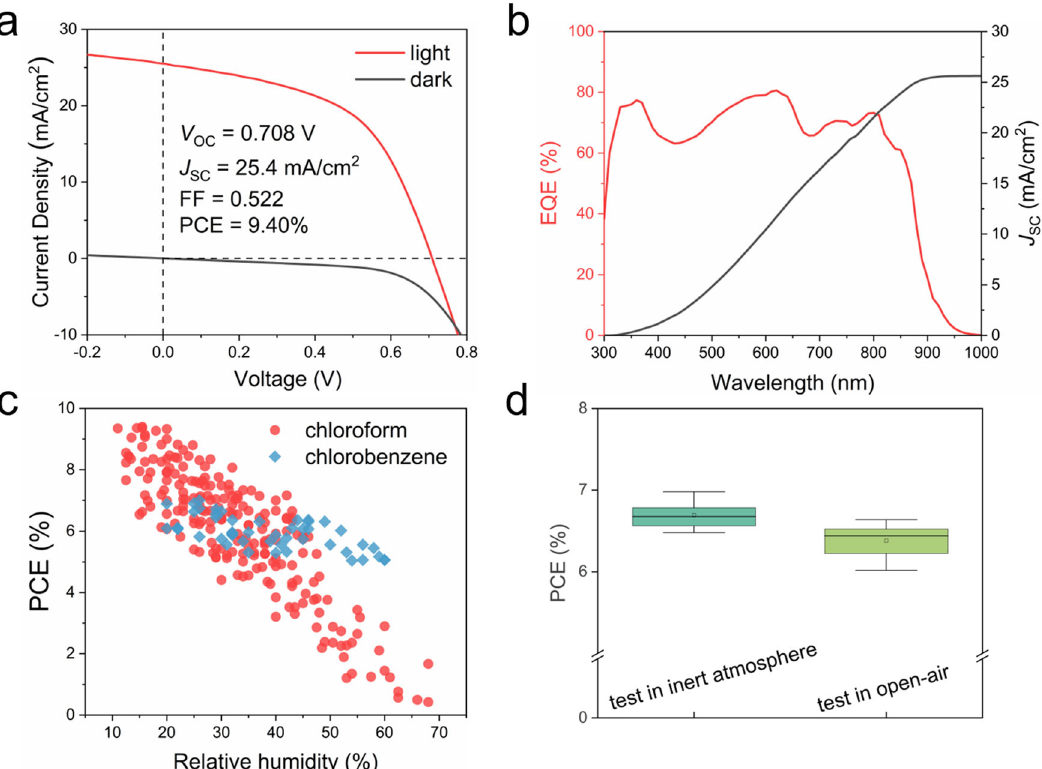
Fig. 3 Photovoltaic performance of the FOSCs. a J – V curves of the champion FOSC device (irradiation length, 5 mm), prepared under 10 – 15% relative humidity. b External quantum ef fi ciency of the device and the calculated J SC . c Statistic PCE of the FOSCs obtained under different room humidity conditions. Chloroform and chlorobenzene are used as the solvent for the organic photovoltaic materials. d Statistical device ef fi ciencies of the FOSCs (prepared under 42-45% relative humidity) tested in open-air and inert atmosphere conditions, the median line and mean value are included in the